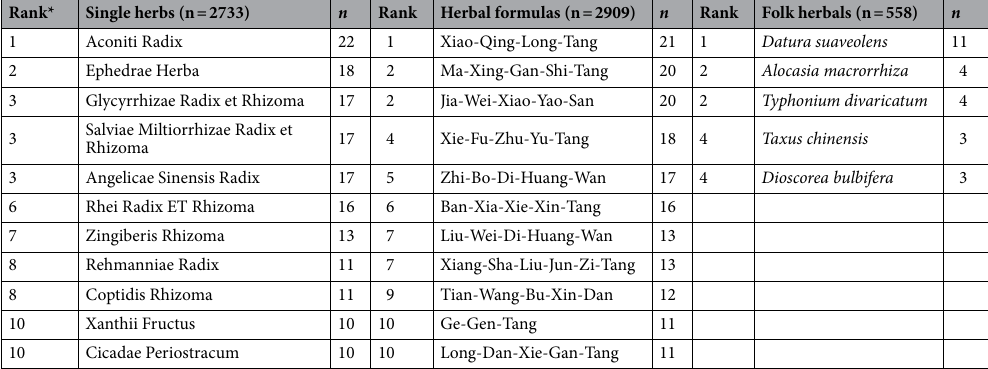
Rank* Single herbs (n =